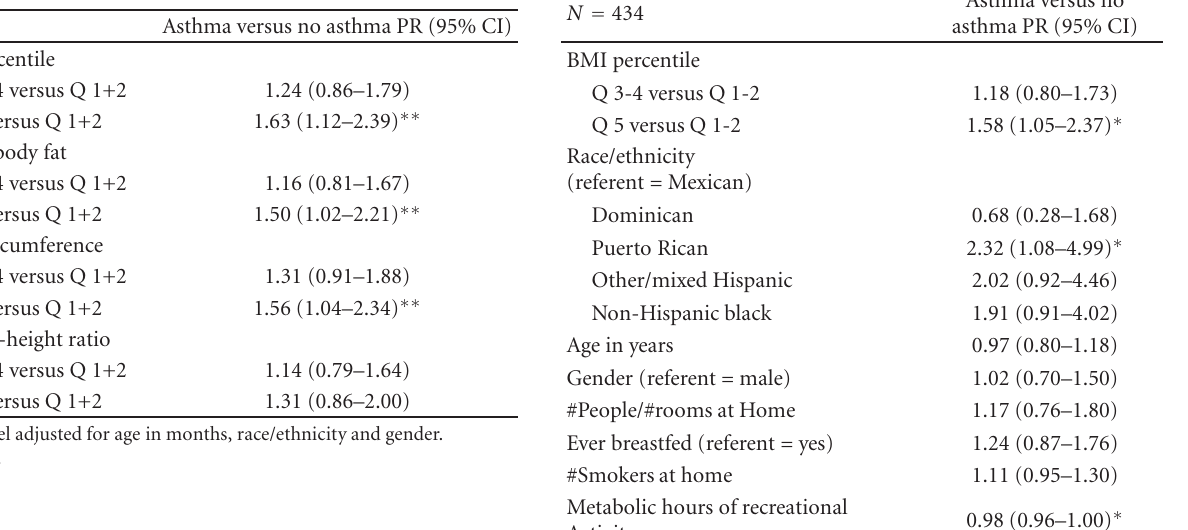
Table 5: Adjusted prevalence ratios for quintiles (Q 1–Q 5) of four body fat measures in relation to physician-diagnosed asthma.